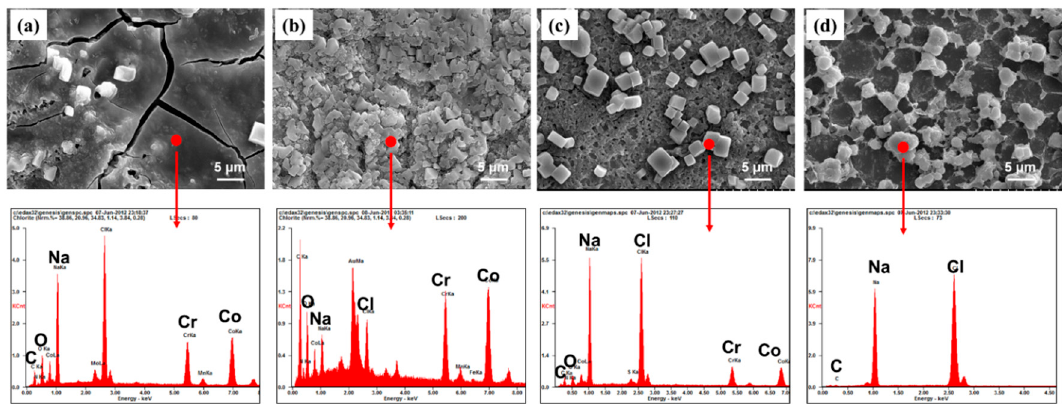
Figure 9. SEM morphologies and EDS of surfaces grafted with CS brushes with different cycles: ( a )